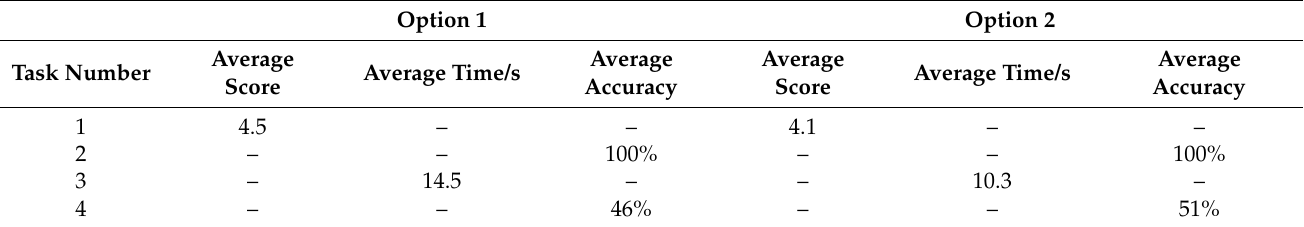
Table 9. Statistical table of test